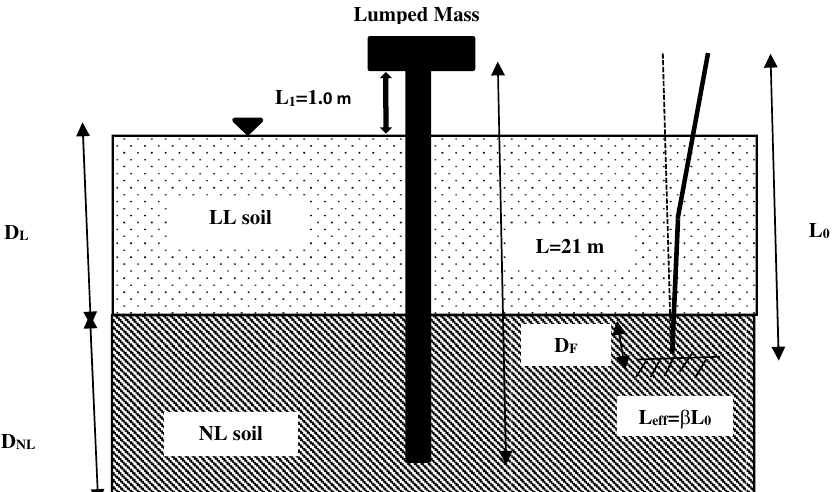
Fig. 3 Schematic diagram of soil-pile system considered in the present study